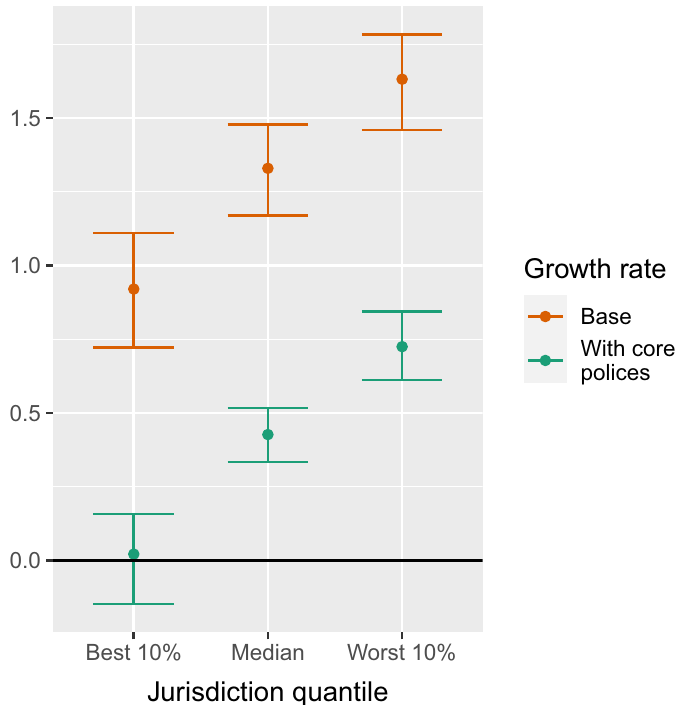
Fig 6. Effects of a set of core policies on weekly growth rate g by quantile of g (base) among all jurisdictions. Core policies include the cumulative effects of C3–2, C4–3, C6–1, C7–1, C8–3, H1–2, H2–2, and H3–2. Dots = median estimates; Lines = 95%